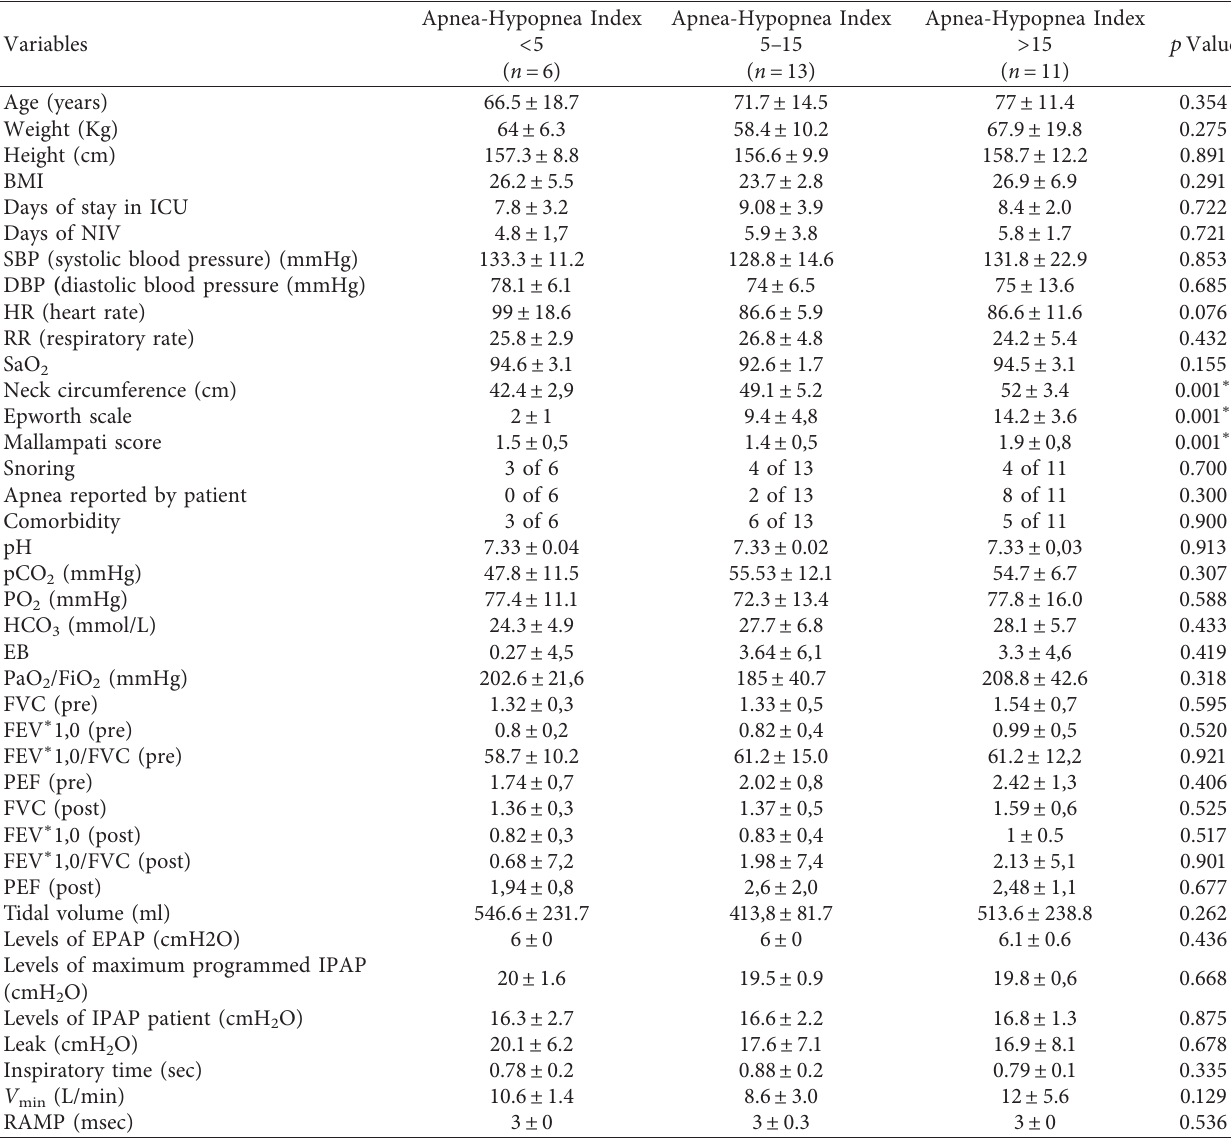
Table 2: The characteristics of group’s severity according to AHI.